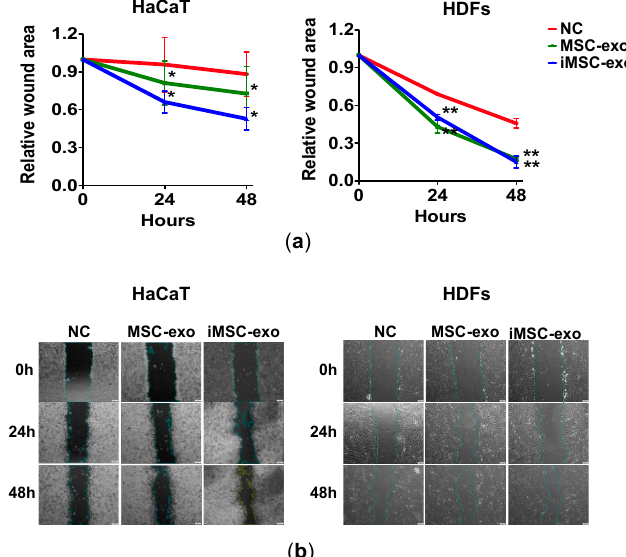
Figure 4. Wound scratch assay of skin cells treated with exosomes. ( a ) Relative wound area changes by exosome treatment. MSC-exo or iMSC-exo were co-incubated with HaCaT (left) or HDFs (right), and the wound area at designated study points was normalized against that obtained at 0 h. NC, negative control (serum-free culture). * p < 0.05, ** p < 0.01. ( b ) Light microscopy images of wound scratch assay at designated study points. The wound area of HaCaT was calculated using inherent protocol in ImageJ software, while that of the HDFs was manually delineated and subjected to ImageJ software analysis. NC, negative control (serum-free culture). Scale bars are 200 µ